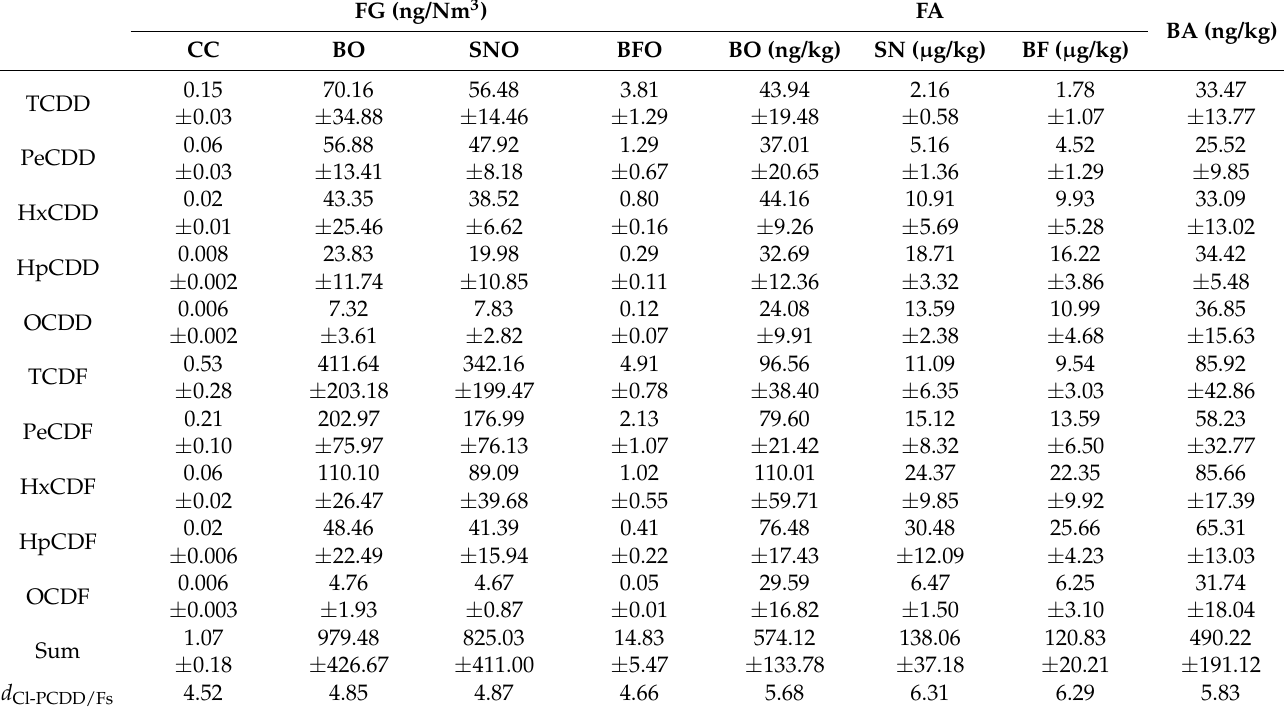
Table 2. Total concentrations of homologues for 136 PCDD/Fs during leather waste